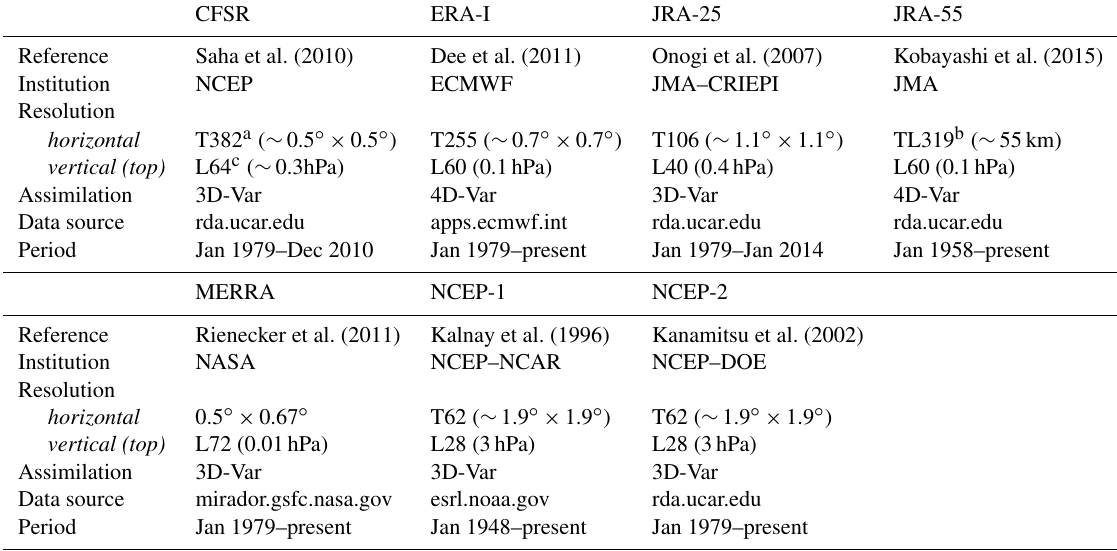
Table 1. Overview of the reanalysis data employed in this study.